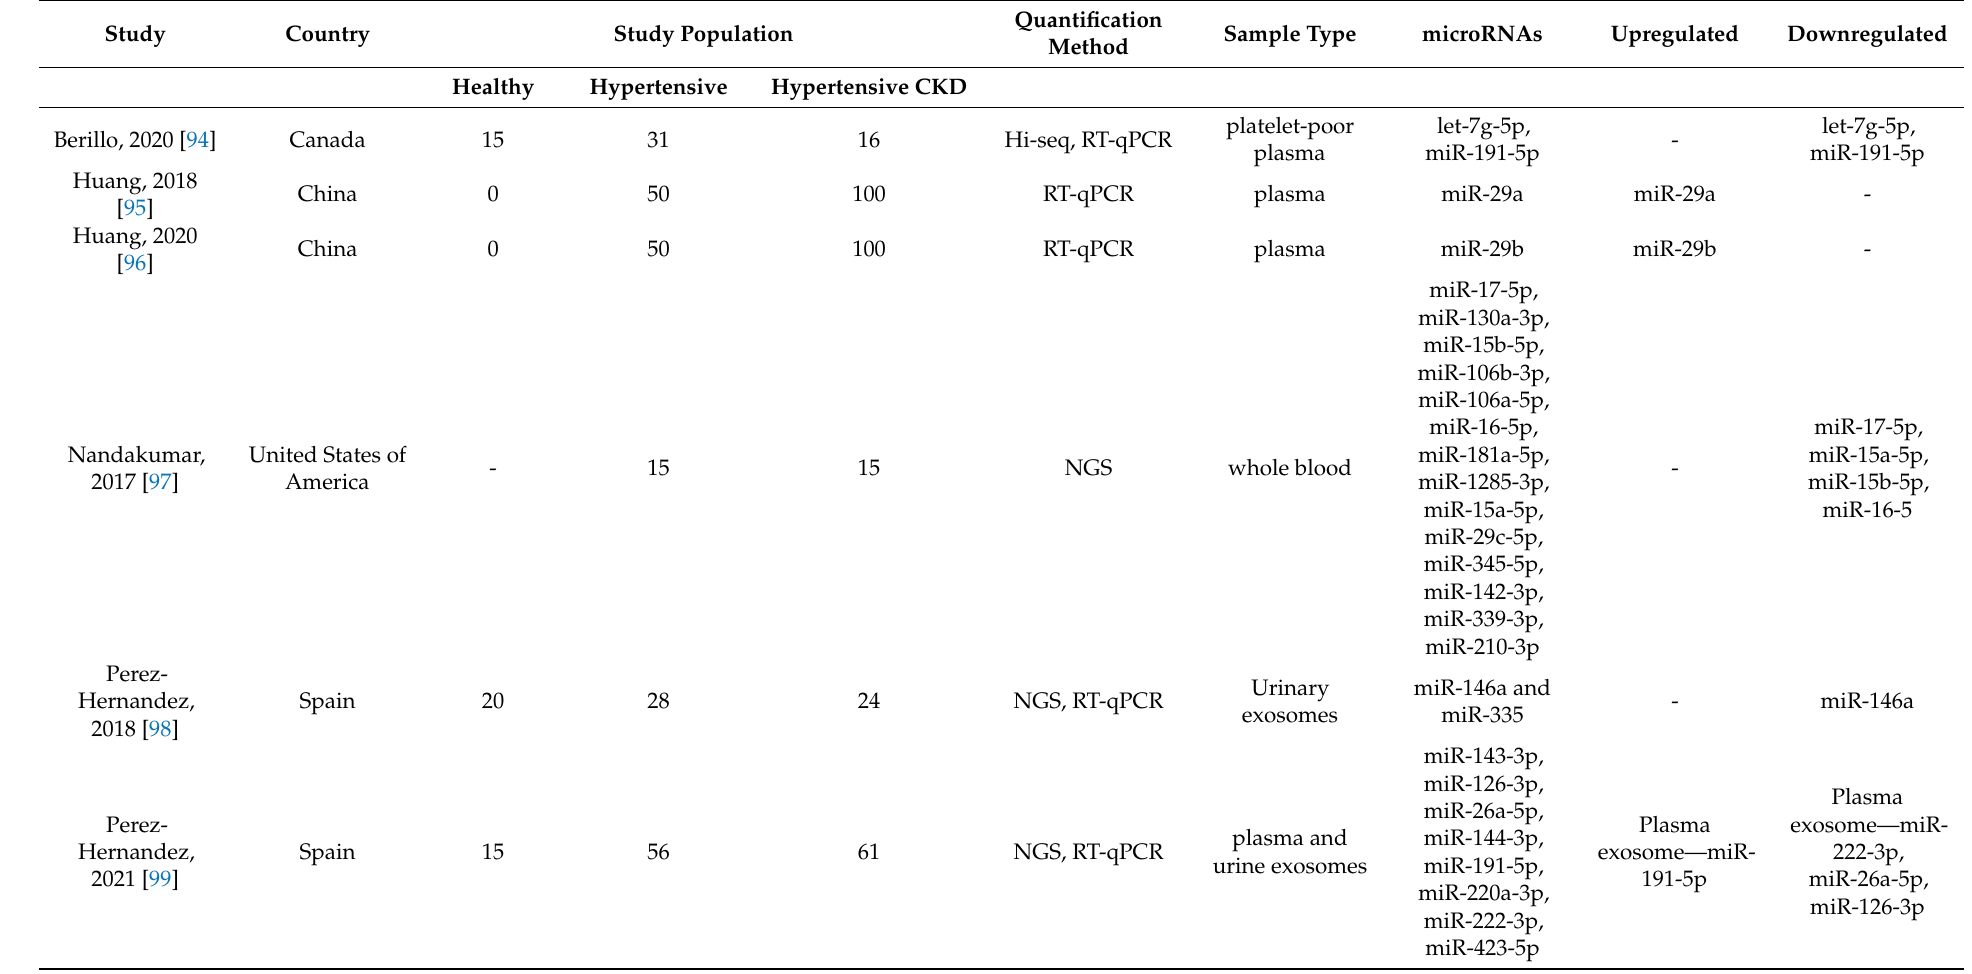
Table 3. Characteristics of studies evaluating microRNA expression patterns in hypertension-associated chronic kidney